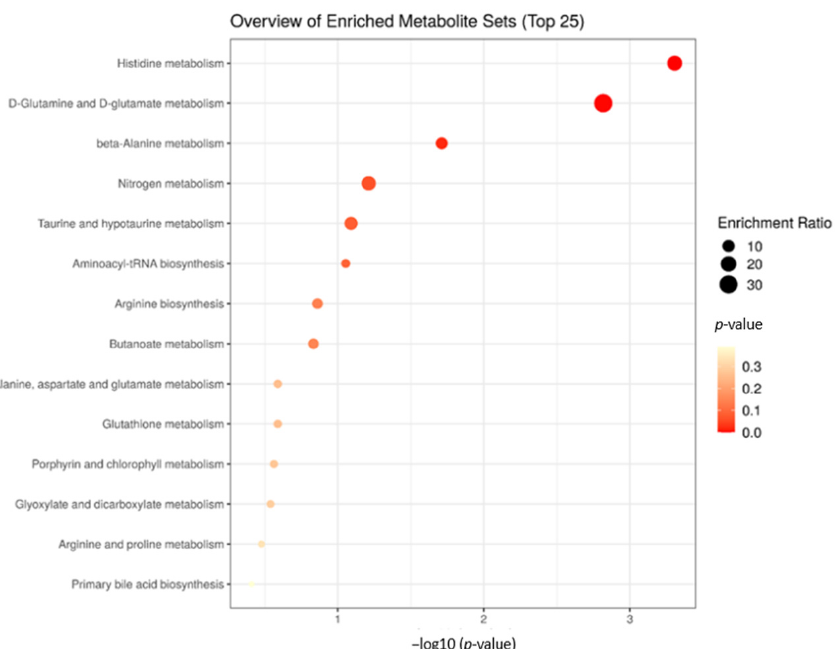
Figure 5. Biological processes involved with significant plasma metabolites of the dams in the pre-delivery stage after receiving the three nutritional treatments (NP, PP, and FP).